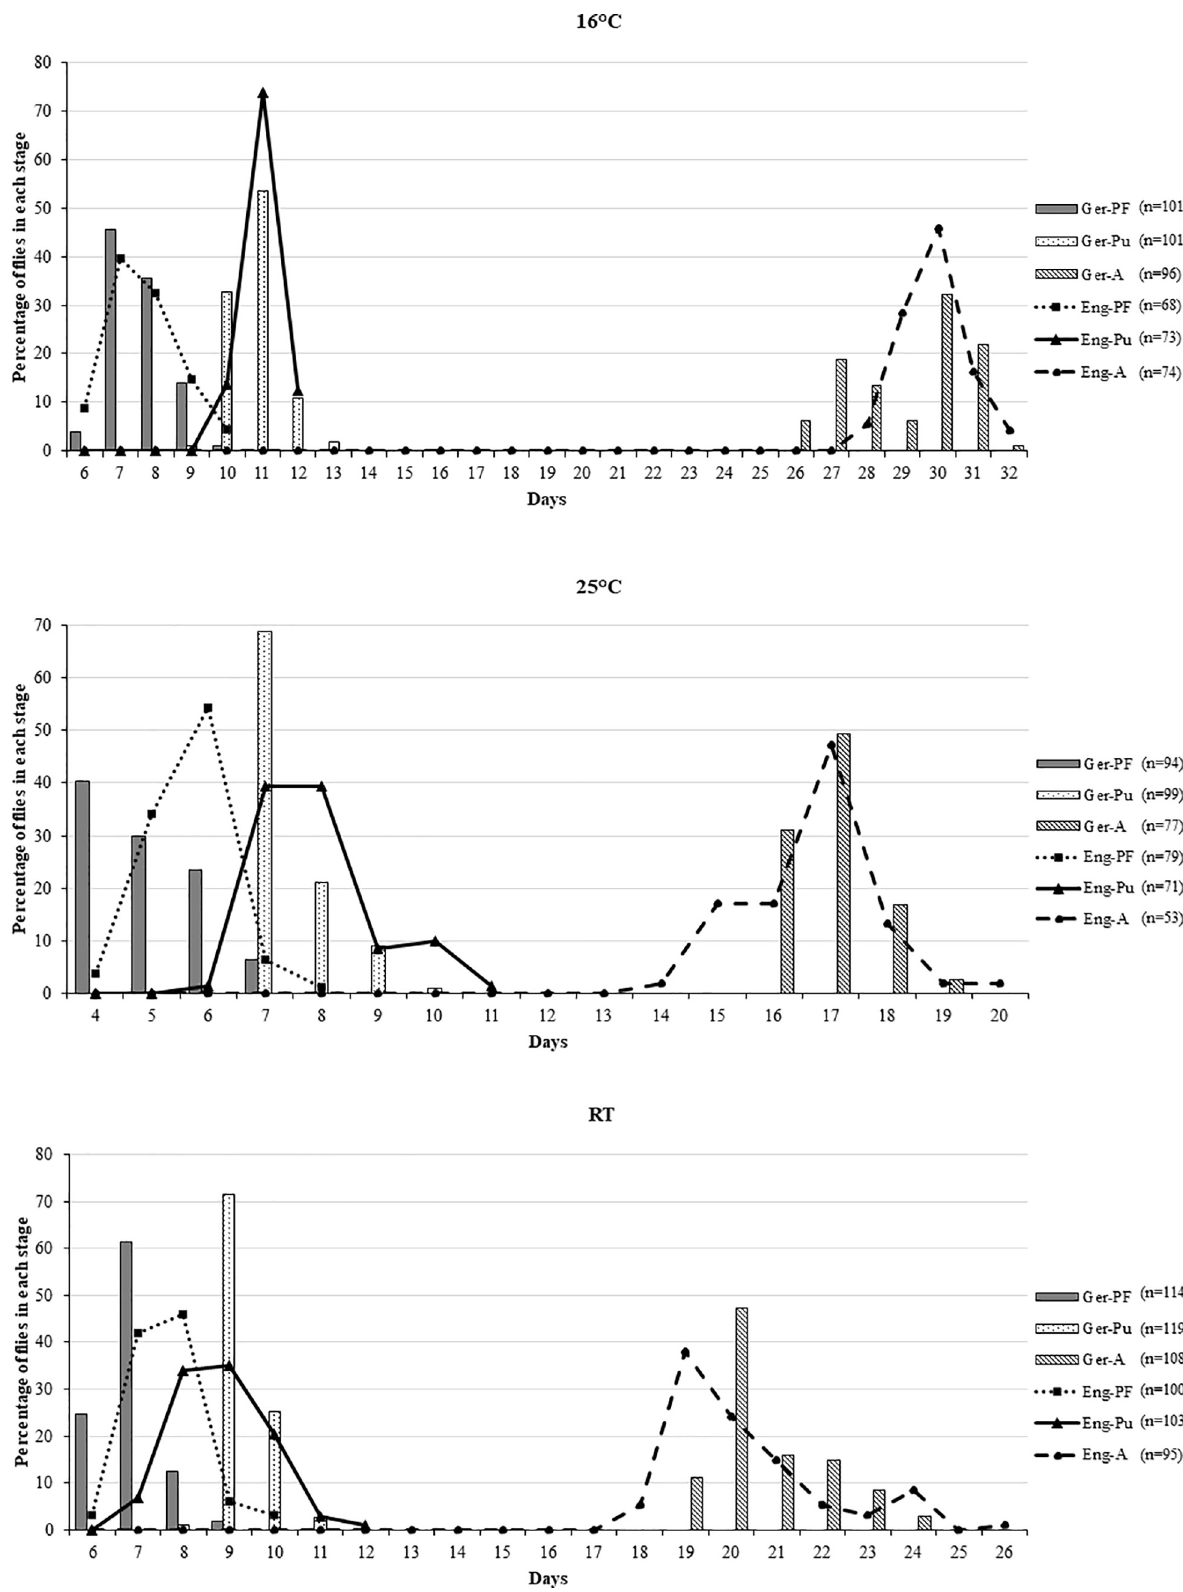
Fig 4. Percentage of C . vicina to reach the post-feeding (PF), puparial (Pu), and adult (A) stages at three different temperatures (25˚C, 16˚C, and RT). https://doi.org/10.1371/journal.pone.0207188.g004 PLOS ONE | https://doi.org/10.1371/journal.pone.0207188 December3,